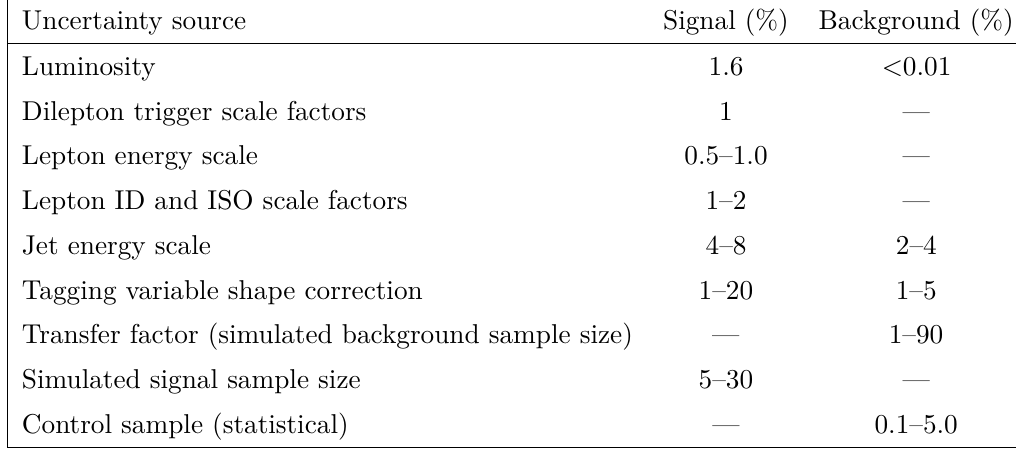
Table 1 . The systematic uncertainties in the background and signal yield expectations. Dashes indicate that the systematic effect is not applicable or is negligible.